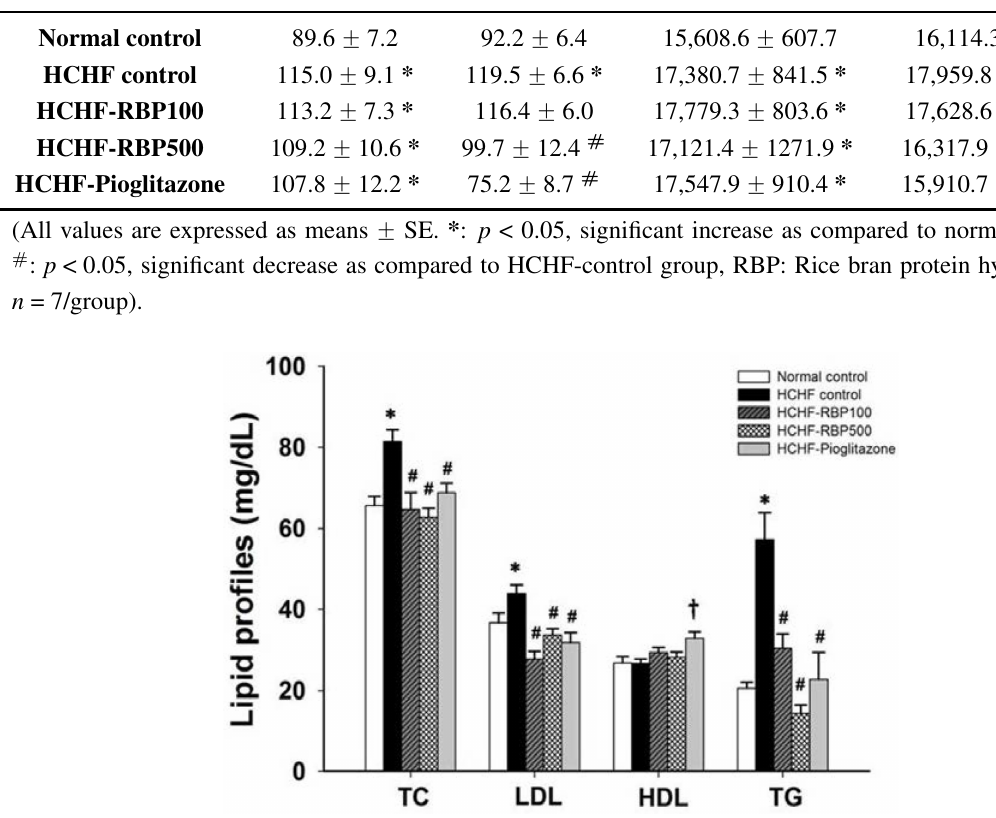
Figure 1. Effect of RBP on serum lipid profiles in HCHF-fed rats. Oral administration